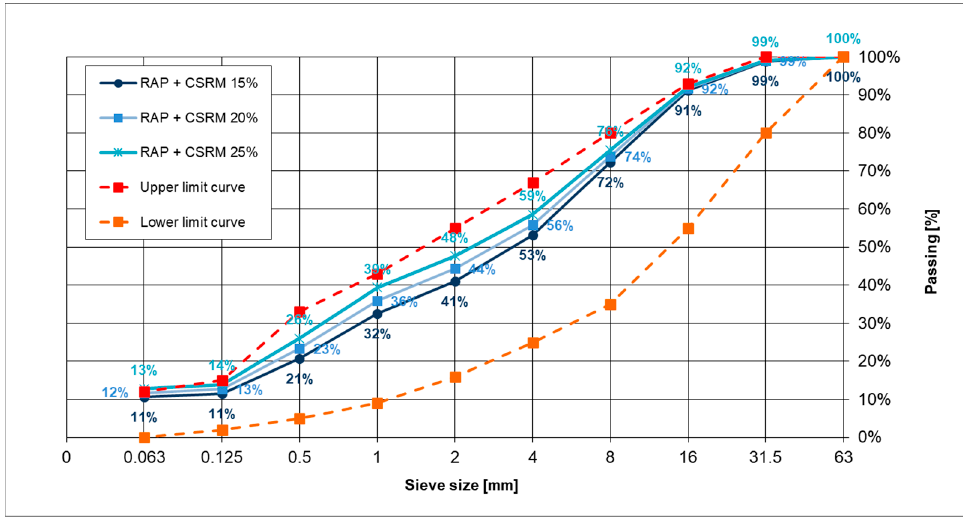
Figure 1. Grading curves of a mineral mix with the addition of “B” cement-sand-rubber mortar applied in the amount of 15, 20, and 25% (m/m).